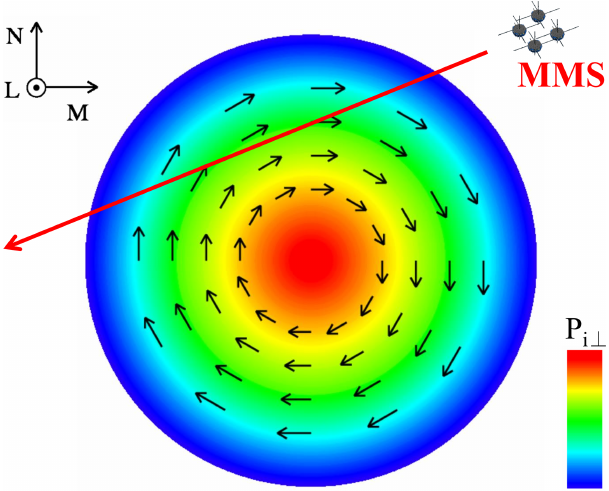
Figure 6. Schematic of MMS1 crossing the magnetic dip in the M – N plane. The colors changing from the center (red) of the magnetic dip to its edge (blue) indicate the decrease in the ion perpendicular thermal pressure as shown by the color bar. The black arrows in the magnetic dip indicate the direction of the ion velocity. The red arrow indicates a possible trajectory of